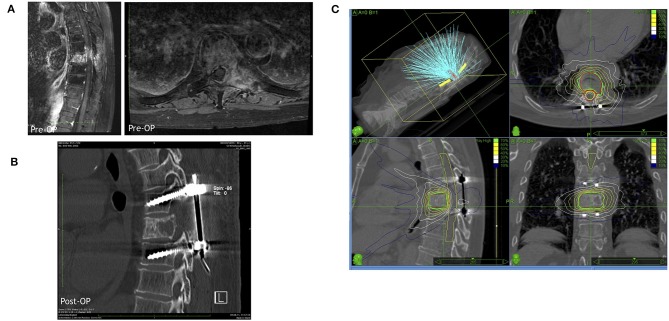
A representative case for a hybrid therapy with a prior surgery including decompression and stabilization followed by a radiosurgical treatment by Cyberknife. (A) Representative MRI images (left in sagittal view and right in axial view) of the metastatic lesion in thoracic vertebra 8. (B) Postoperative CT scan demonstrating the decompression in the lesional segment and dorsal spinal fusion of thoracic vertebra 7 and 9. (C) The Cyberknife treatment planning of the lesional vertebra body after surgery.